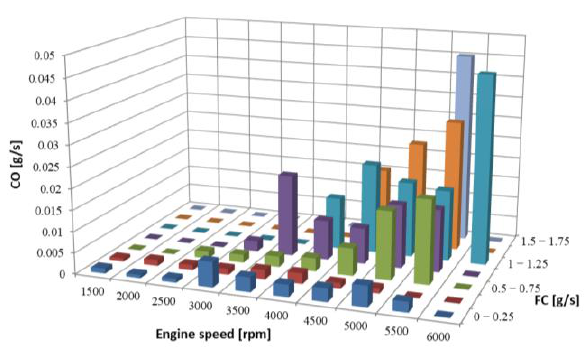
Fig. 9. CO emission per second as a function of engine speed and fuel consumption ranges